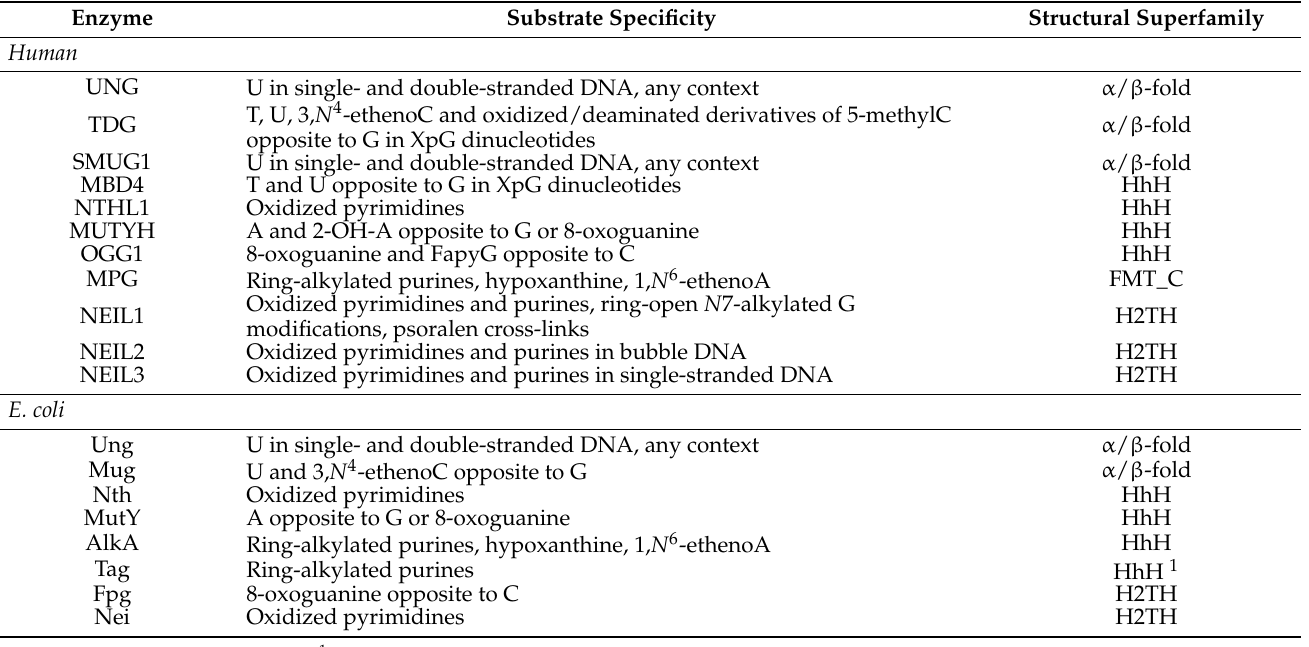
Table 1. DNA glycosylases from humans and E. coli